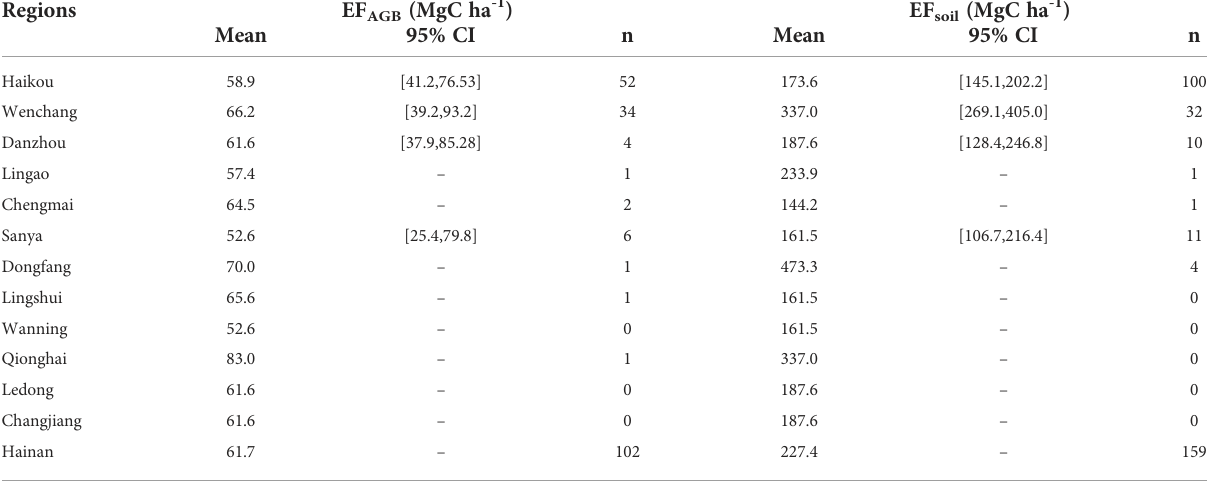
TABLE 3 The EF AGB and EF SOC of mangroves in Hainan Regions EF AGB (MgC ha -1 ) EF soil (MgC ha -1 ) Mean 95% CI n Mean 95% CI